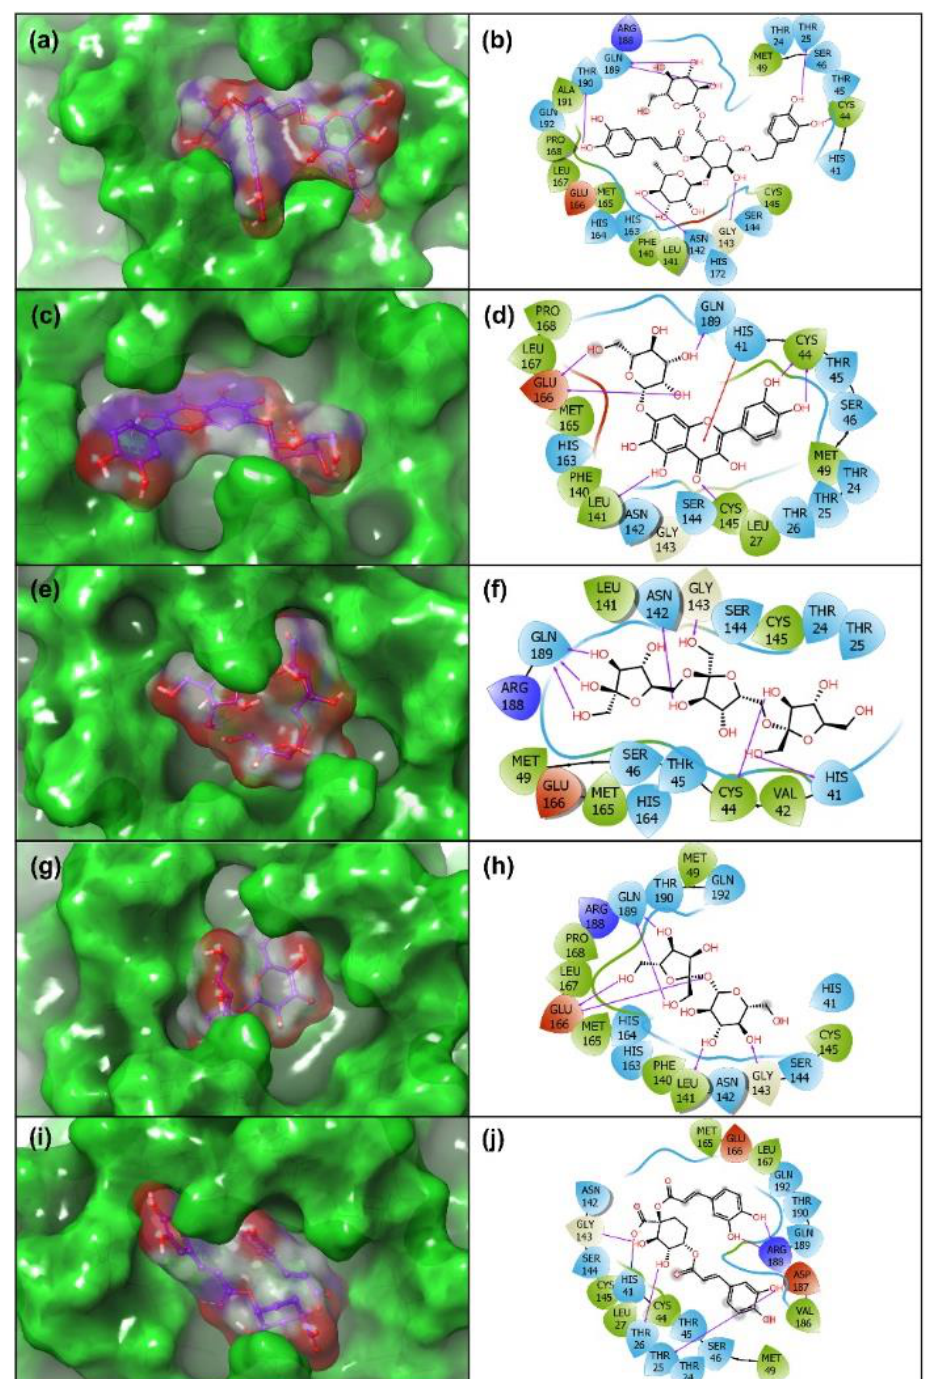
Figure 4. 3D and 2D interaction maps for the docked poses of SARS-CoV-2 M pro with potent natural products, i.e., ( a , b ) Echinacoside, ( c , d ) Quercetagetin 7-glucoside, ( e , f ) Levan N, ( g , h ) Inulin from chicory, and ( i , j ) 1,3-Dicaffeoylquinic acid. In 3D interaction poses, the docked ligand surface was generated based on partial charge while protein surface was rendered based on secondary structure. In 2D maps, hydrogen bond formation (pink arrows), hydrophobic (green), polar (blue), red (negative), violet (positive), glycine (grey), π - π stacking (green line), π -cation stacking (red line), and salt bridge (red-blue line), interactions are logged for docked complexes of SARS-CoV-2 M pro with selected natural products.